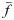
Direction selectivity indices for the FM-sweeps of the experiment.DSI↑ and DSI↓ to sweeps with different f‾ and |Δf|. DSI is defined as the proportional activity to up in comparison to down sweeps in a given network.